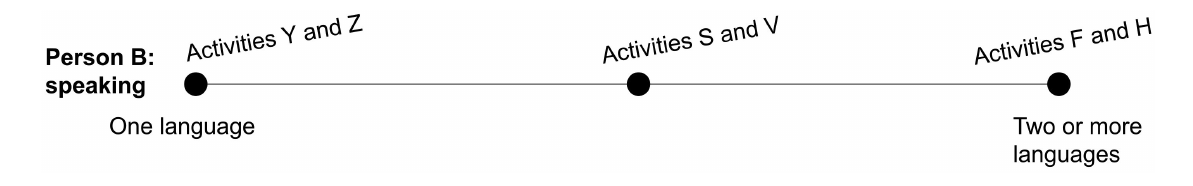
FIGURE 3 An illustration of how a person’s speaking proficiency is differently distributed across all of the activities this person engages in in life (e.g., communicating with coworkers, bargaining at a flea market, participating in a religious ceremony). Some or all of the different canonical language skills may be at play in each of these activities. The continuum displayed in this figure represents how proficiency in a single skill (here, speaking) can be distributed across different activities for the same person. Person B’s speaking abilities in activities Y and Z might be limited to one language (e.g., they can do Y only in English, and Z only in French), whereas in activities F and H they can speak fluently in two or more languages. It could be that, for this specific person, if they could engage in activity Y (say, contacting their landlord) in writing rather than orally, their ability to succeed in that situation would be greatly